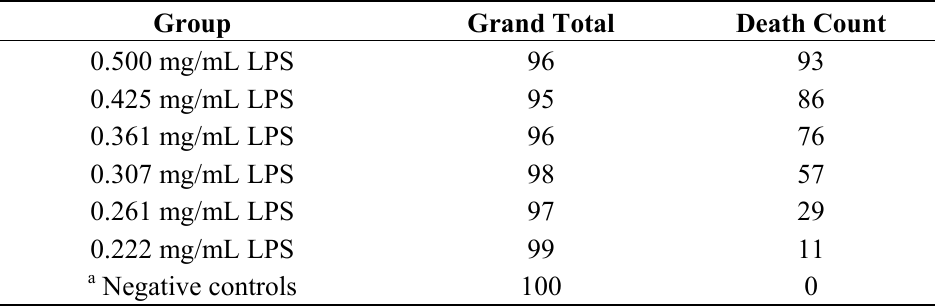
statistics of 50